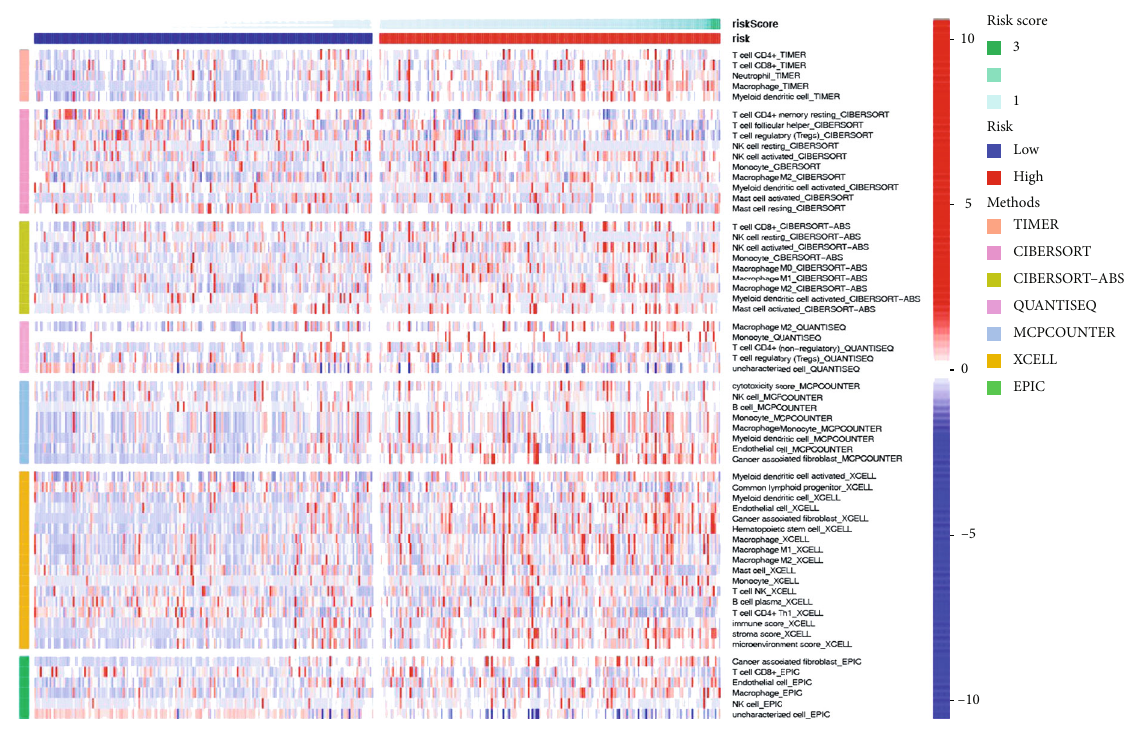
Figure 8: Heat maps of the high- and low-risk group immune responses based on Timer, Cibersort, Cibersort-abs, Quantiseq, MCPCounter, Xcell, and EPIC algorithms. Red represents high expression of immune cells, and blue represents low expression of immune cells.